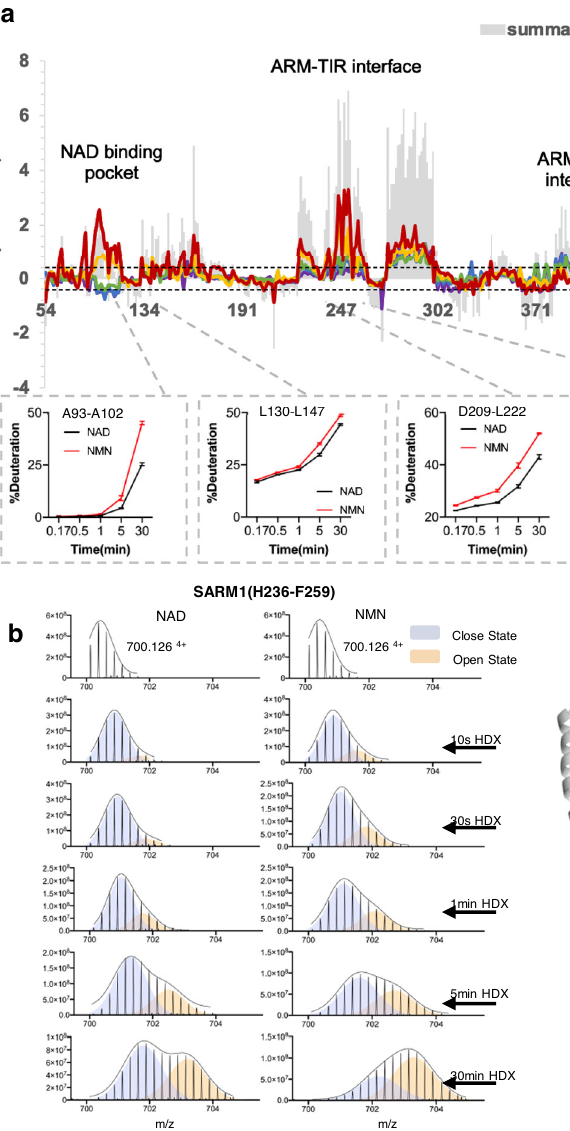
HDX incorporation in the presence of NAD or NMN for several representative peptidesareshown. b BimodalisotopicenvelopesfortheSARM1helix α 13(peptide spanning residues 236 – 259). Relative amount in the closed and open state in the presence of NAD and NMN as seen by HDX. Deuteration time points are indicated. Open-to-close transition kinetics for SARM1 helix α 13 is calculated by a fi t of two gaussians.The fi ttedpeakareaparameterwasusedtocalculatetherelativeamount of open state by taking the ratio of high and the sum of the high and low mass subpopulations. c Structure of the NAD bound SARM1 showing ARM-TIR domain interface with the ARM helix α 13 indicated in red. NAD ligand is shown as a stick model. All of the experiments were technically replicated three times ( n =3 inde- pendent experiments, mean±SD). Source data are provided as a Source Data fi